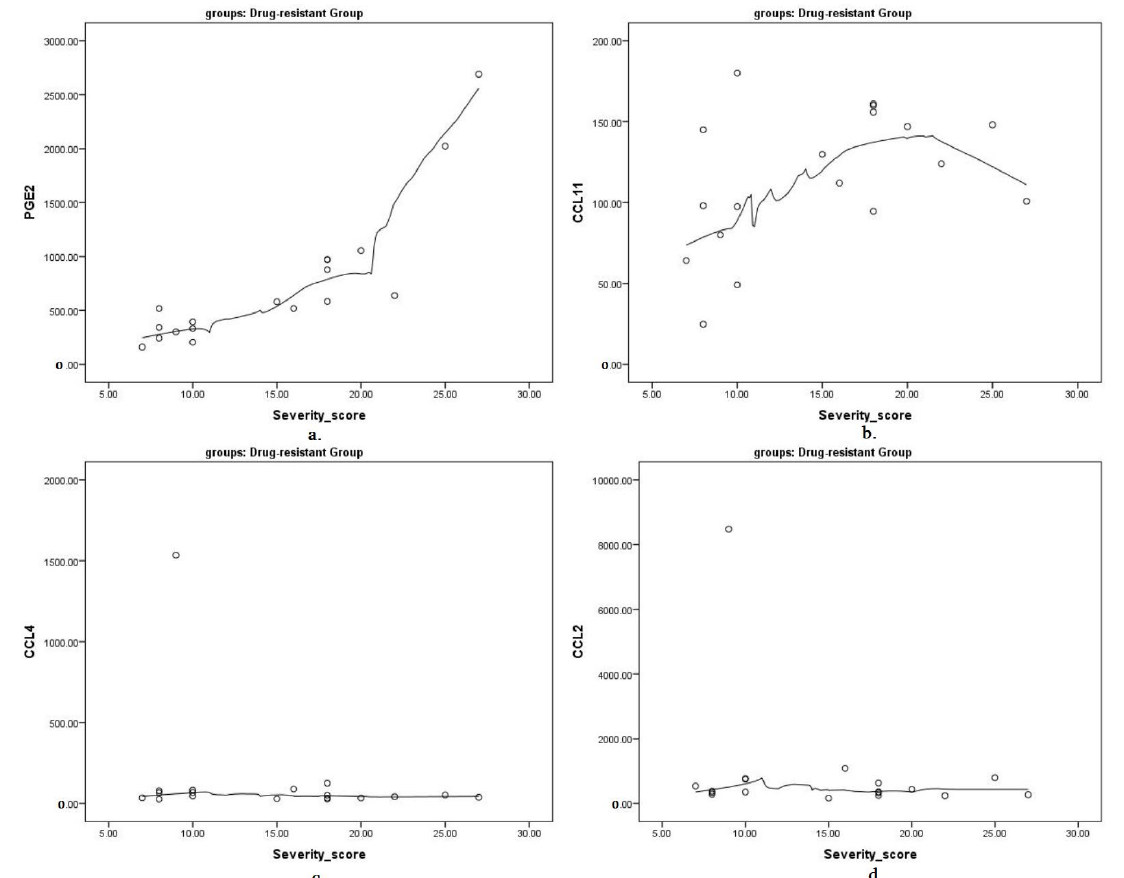
Figure 2. Correlation of targeted proinflammatory cytokines in pg/mL and seizure frequency per month presented as scatterplots: ( a ) PGE2 and seizure frequency; ( b ) CCL2 and seizure frequency;